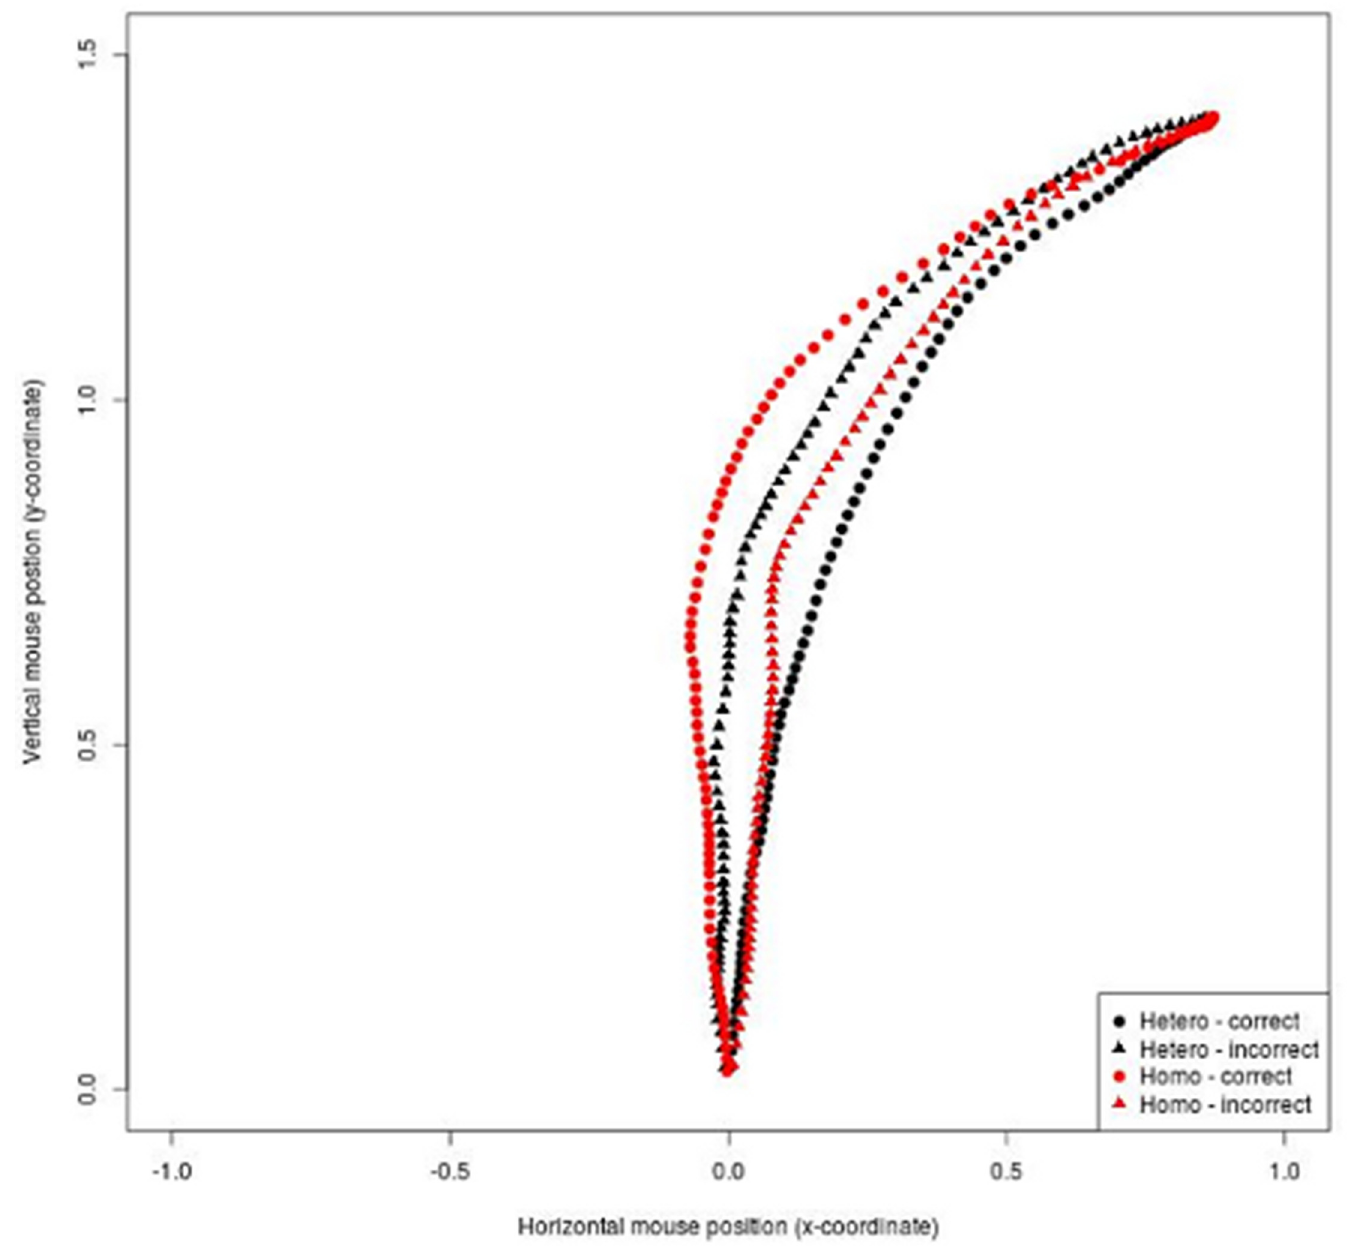
Fig 1. Experiment 1A (Italians): Mean mouse trajectories for correct and incorrect responses for heterosexual and gay